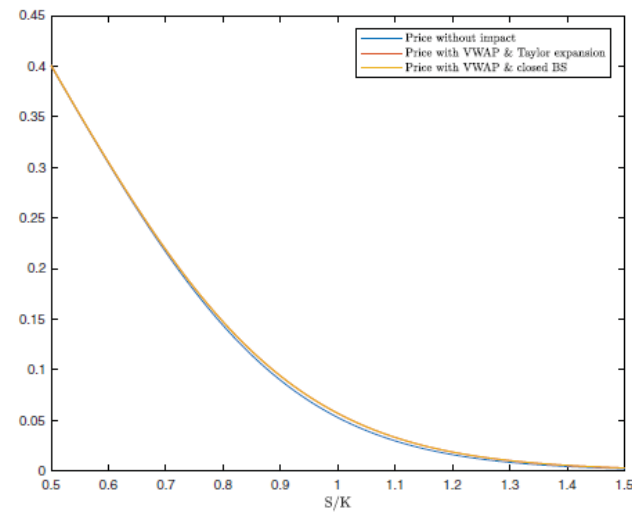
Fig. 5. Put price as a function of the